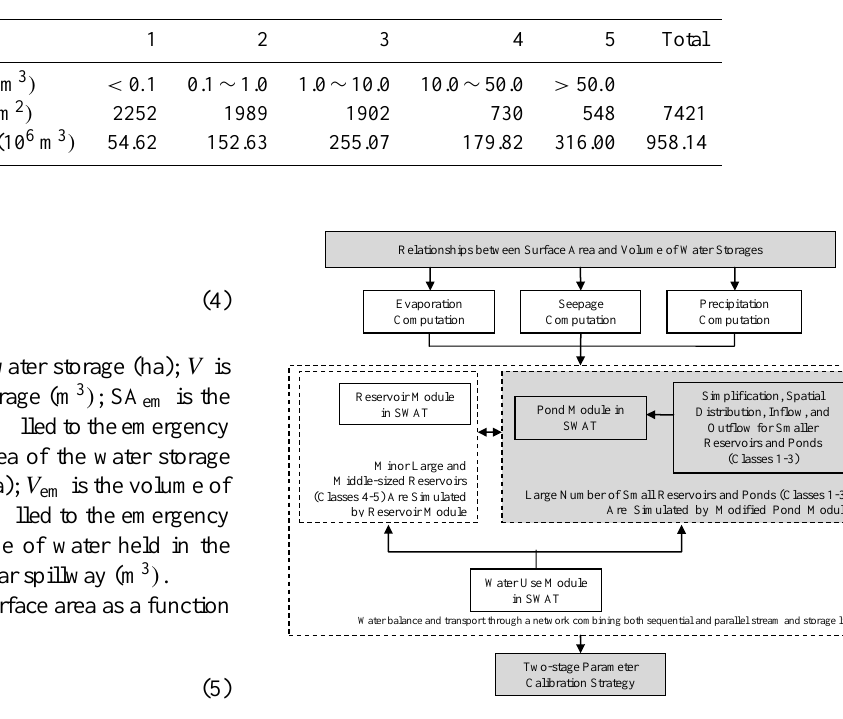
Table 1. Classification of water storages and the total drainage area and storage volume of each class in the Fengman Reservoir Basin.